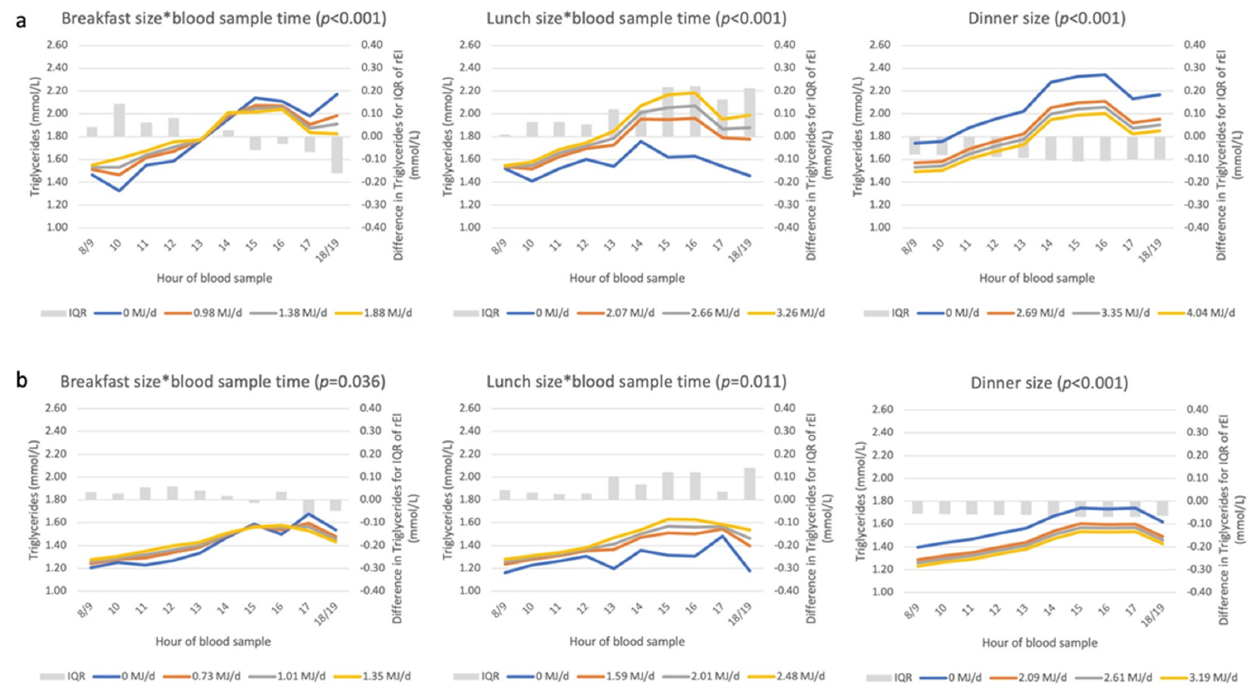
Figure 4. Associations between rEI at three recording sections (“meal size”) and triglyceride con- centrations among men ( a ) and women ( b ). Abbreviations: DEI, daily energy intake (MJ/d); IQR, interquartile range; rEI, reported energy intake. The p -value represents the statistical significance of the interaction term between rEI and time (*), as assessed with the F-test. Where the interaction term was non-significant, the p -value is the statistical significance of the recording section size, as assessed with the F-test. See Appendix D for description of axes, model and interpretation of the graph.